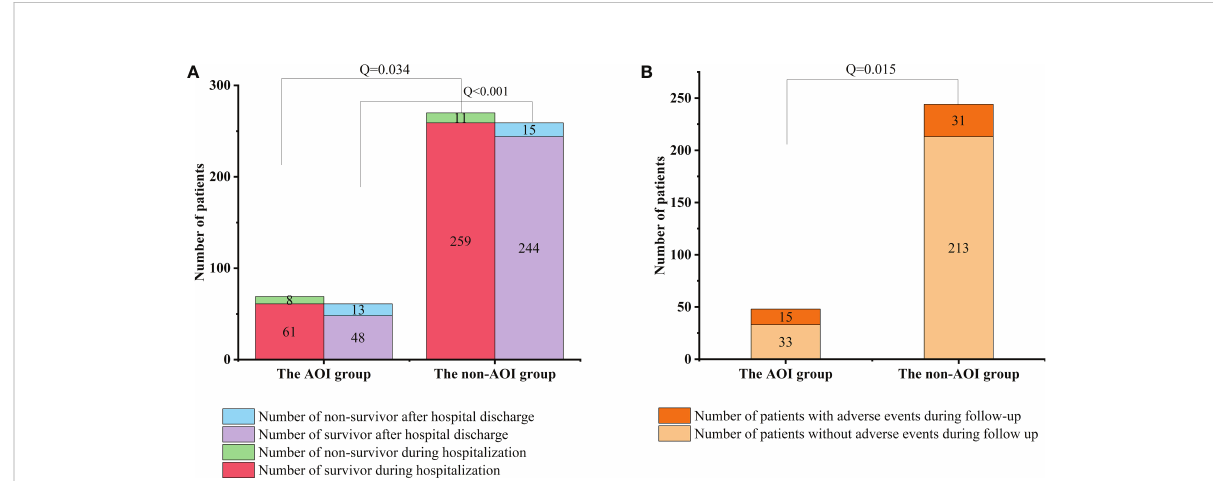
FIGURE 3 Comparison of mortality and follow-up between two groups during hospitalization and after discharge. (A) Comparison of mortality between the AOI group and non-AOI group during hospitalization and after discharge [8 (11.59%) vs. 11 (4.07%), P = 0.034; 13 (21.31%) vs. 15 (5.8%), P < 0.001]. (B) Comparison of follow-up between the AOI group and non-AOI group after discharge [15 (24.59%) vs. 31(11.97%), P = 0.015].